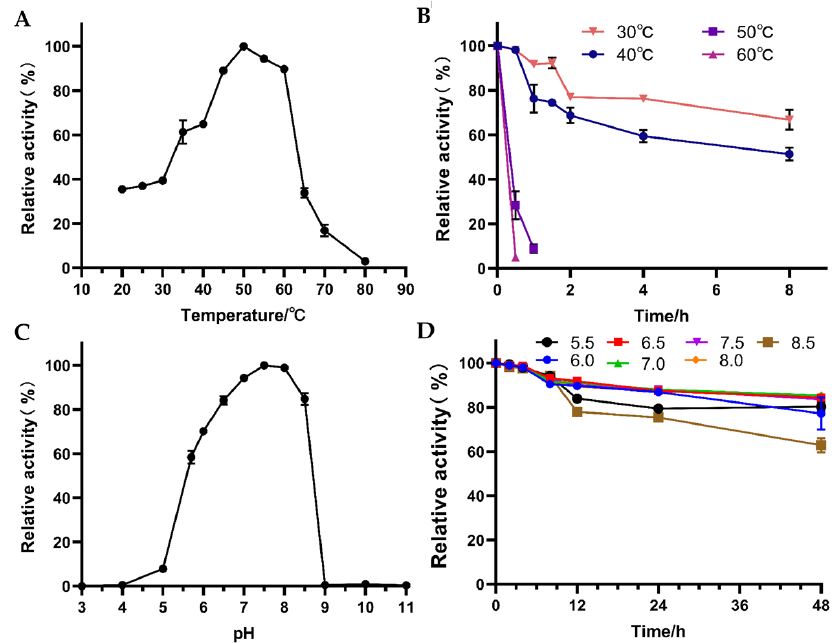
Figure 5. Effect of temperature and pH on enzyme activity and stability of W826-RS0111485 . ( A ) is the effect of temperature on enzyme activity, ( D ) is the effect of temperature on enzyme